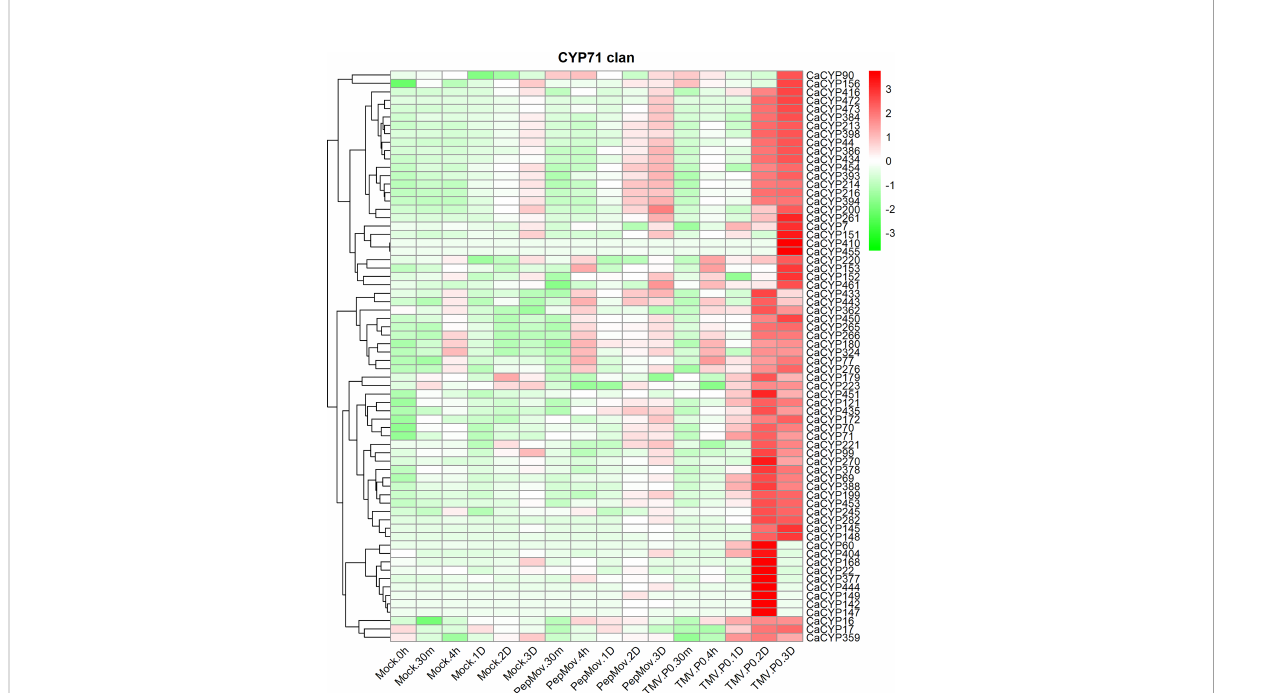
FIGURE 9 Analysis of the expression patterns of the selected CaCYP genes in different virus infections. Heatmaps of normalized RNA-seq data prepared from three biological replicates. The high-expression level is marked by red color, and the low-expression level is marked by green color. Expression levels after virus treatment, including tobacco mosaic virus (TMV) and pepper mottle virus (PepMoV). Different time points include 30 min, 4 h, 1 day, 2 days, 3 days, and up. The control group is represented by the Mock